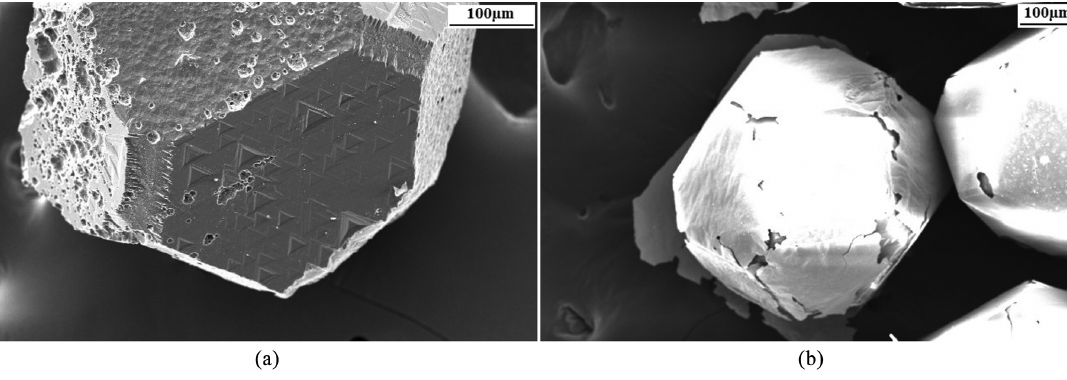
Figure 7. Diamonds (a) without coating and (b) with Ti coating, after heat treatment during 60 min.